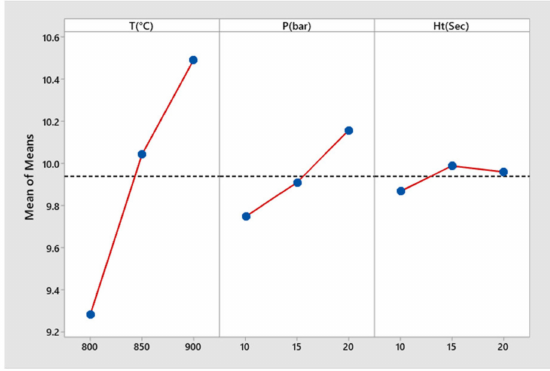
Figure 10. Main effects plot for